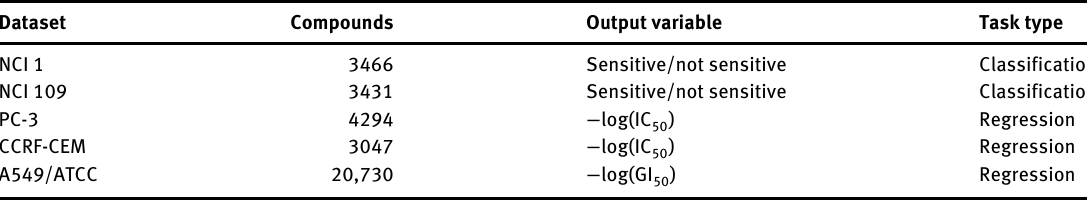
Table 1: Details on the datasets used in this